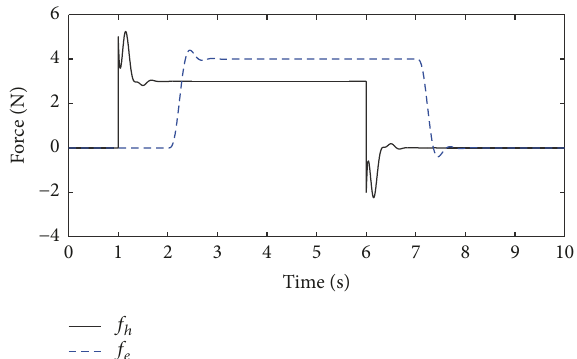
Figure 10: Force tracking performance ( 𝑇 1 = 𝑇 2 = 1 s).